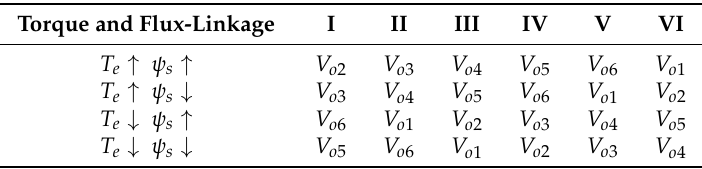
Figure 7. Reconstructed voltage vectors under phase B open-circuit fault. Table 2. Switch table when phase B in open-circuit fault.